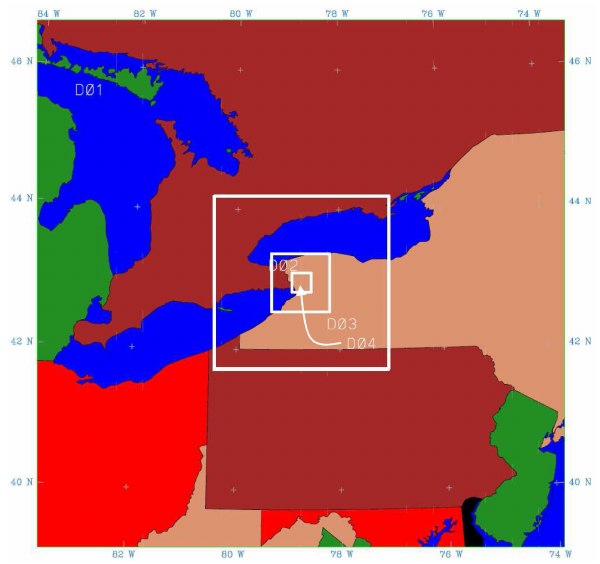
Figure 3. Four nested model domains in MM5 and WRF, centered at Bu ff alo.